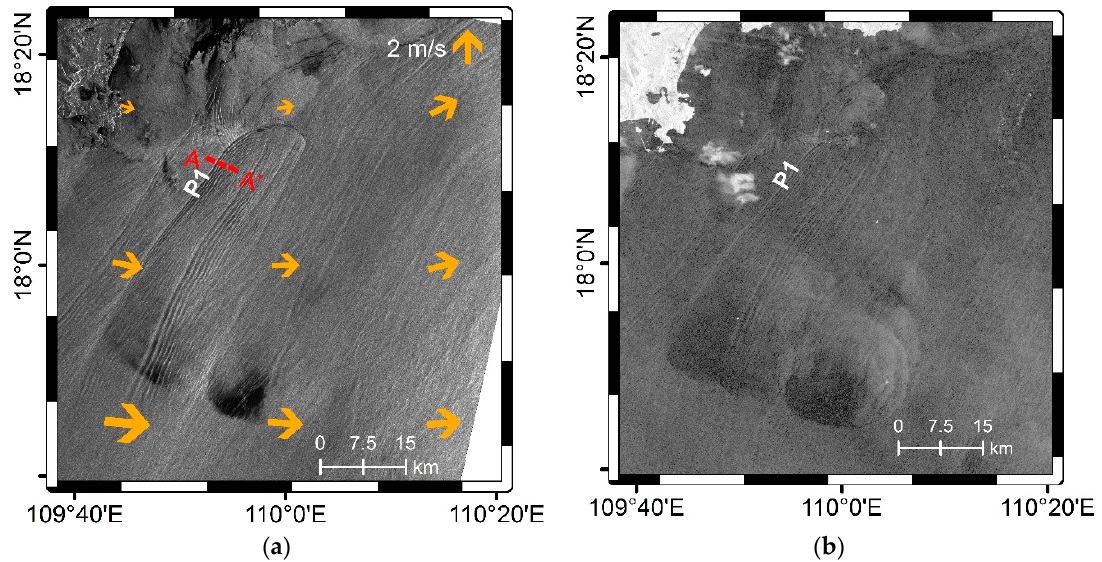
Figure 2. A portion of ( a ) the GF-3 SAR image acquired at 22:43 UTC on 10 June 2017 and ( b ) a TS-X image acquired at 22:32 UTC on 10 June 2017. The yellow arrows superimposed on the GF-3 sub- image show the ERA5 reanalysis sea surface wind vectors (hourly available at 0.25 degree grids) at 23:00 UTC on 10 June 2017.